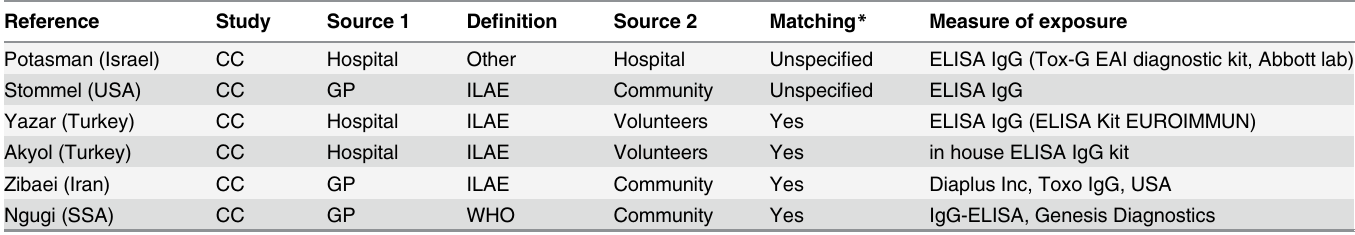
Table 1. Description of studies included in the meta-analysis of association between toxoplasmosis and epilepsy.